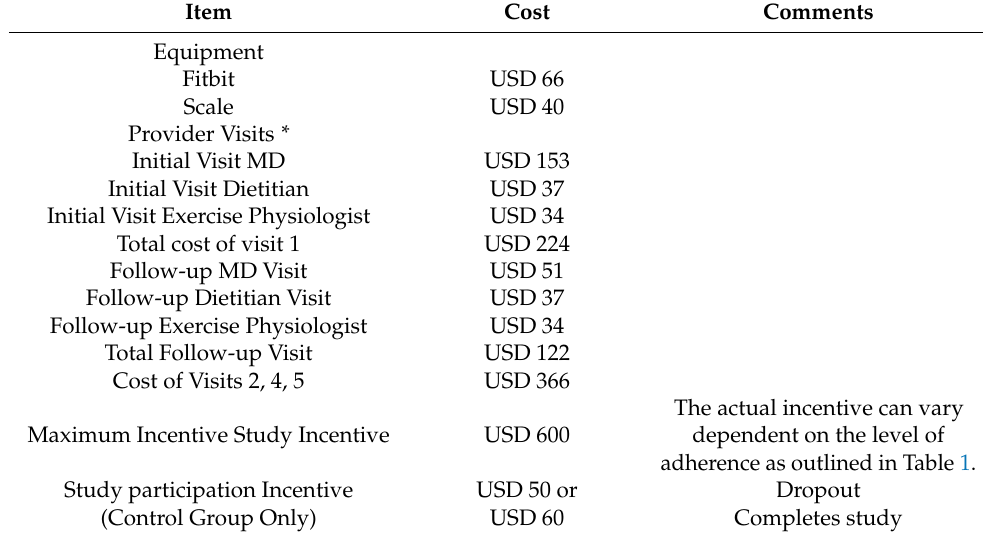
Table 3. Projected study